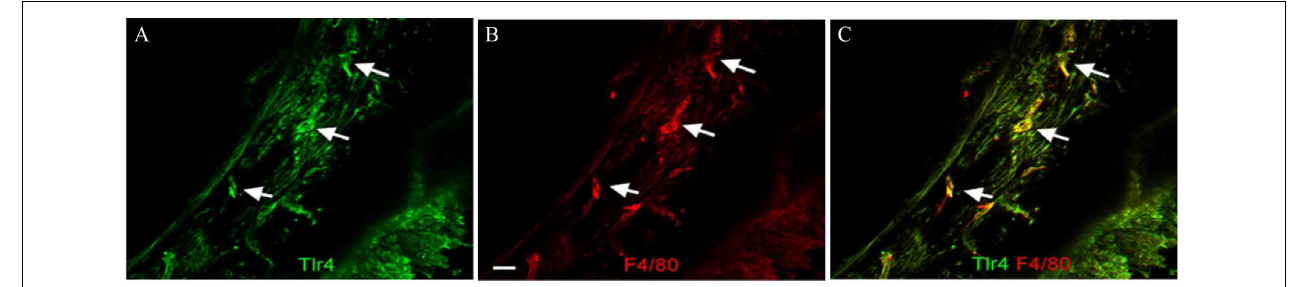
FIGURE 5 | TLR4 expression in macrophages of the basilar membrane. (A) TLR4 is expressed in cells of the basilar membrane. Arrows indicate TLR4-positive cells. (B) Double labeling of the macrophage marker protein F4/80 in the same tissue. (C) Merged images of panels (A,B) . The TLR4-positive cells are also F4/80 positive. Scale bar = 20 µ m [citing from Vethanayagam et al.